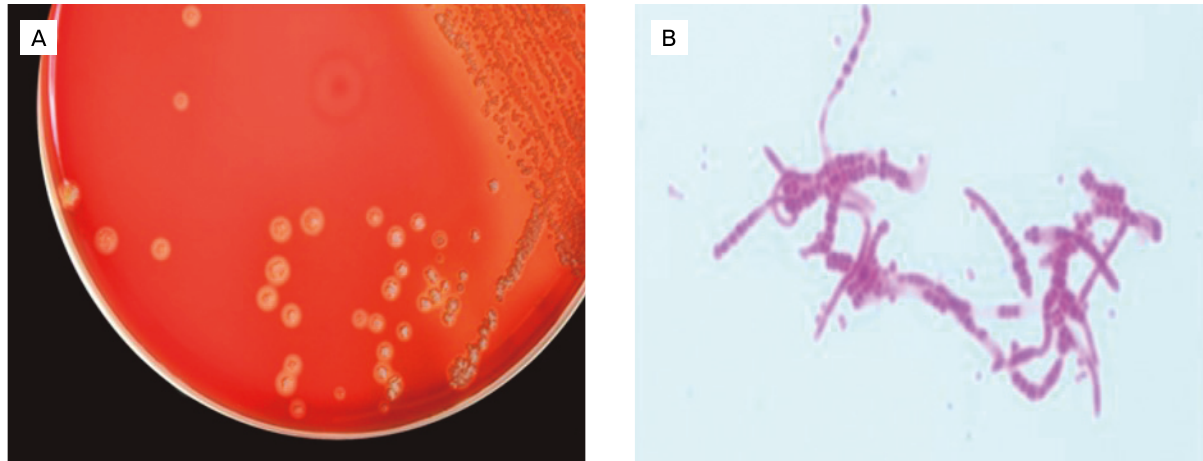
conditions, after 48 hours 2